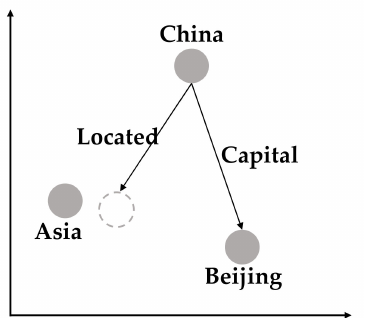
Figure 1. Embedding